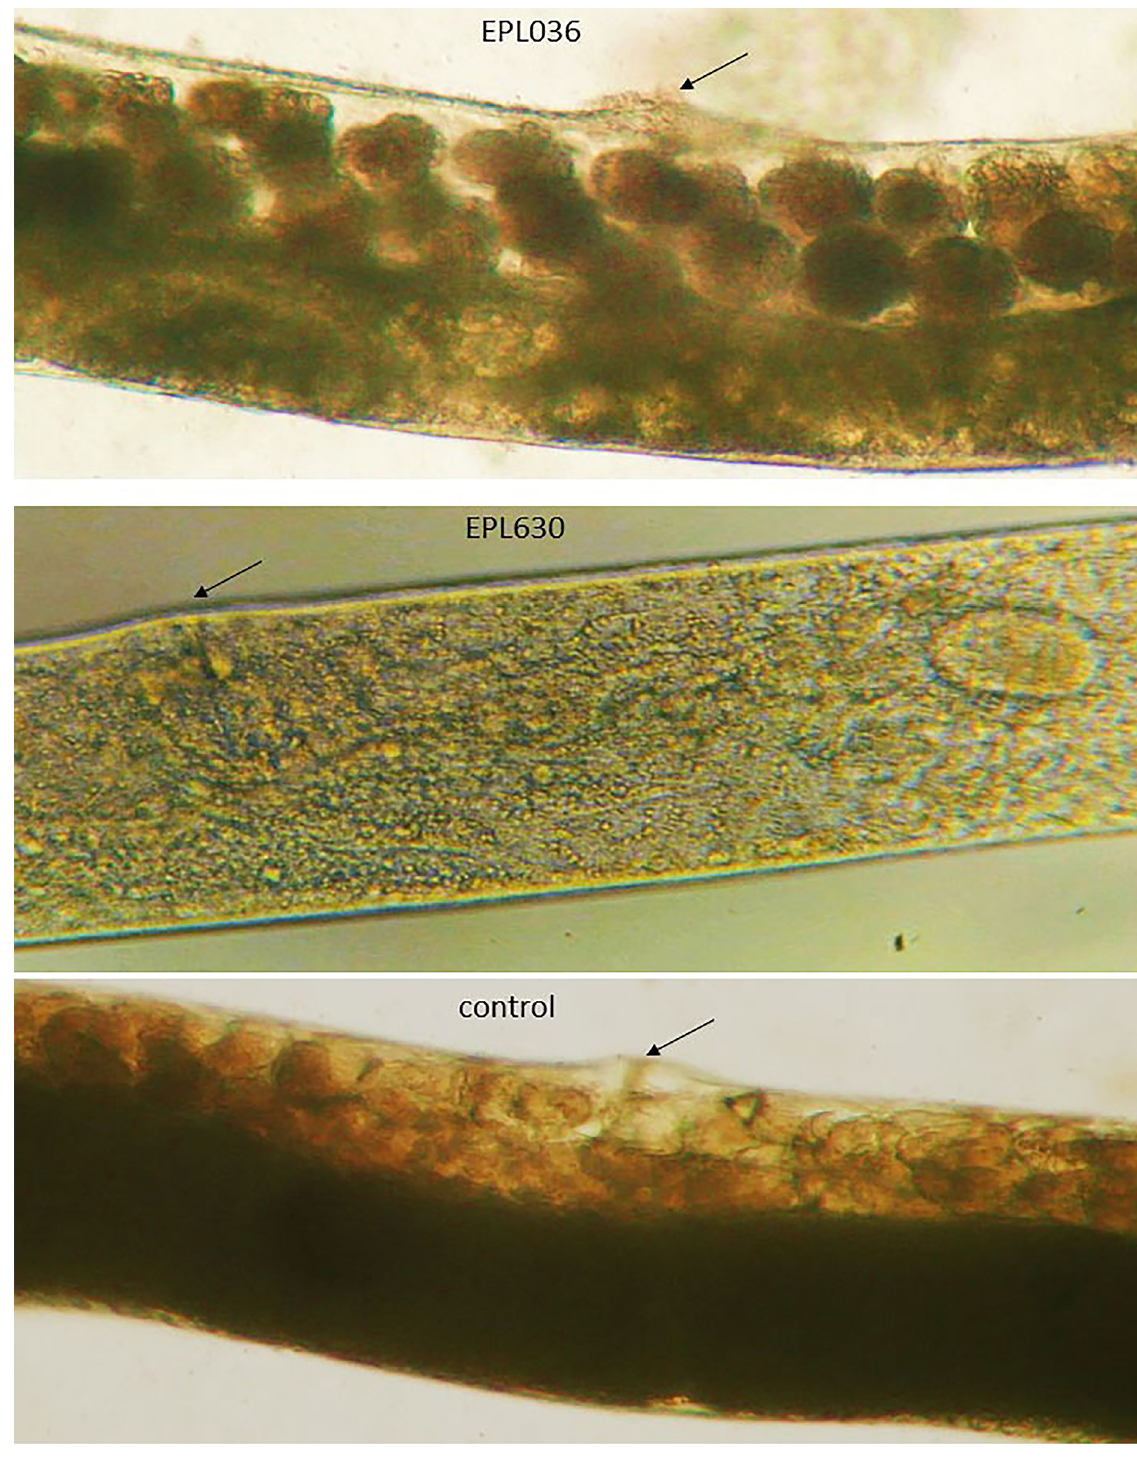
Fig 3. Nematode egg production. Representative mid-body photomicrographic images of adult female nematodes ( Steinernema siamkayai ) after 48h exposure to hexamer peptides EPL036 and EPL630 or unexposed to peptide (‘control’). Images obtained using a dissecting microscope at x10 magnification. Eggs appear as dark roundels in the upper image (EPL036). Fewer eggs are visible in the untreated control and fewest of all in the EPL630-exposed worm. Arrows incidate vulvas.